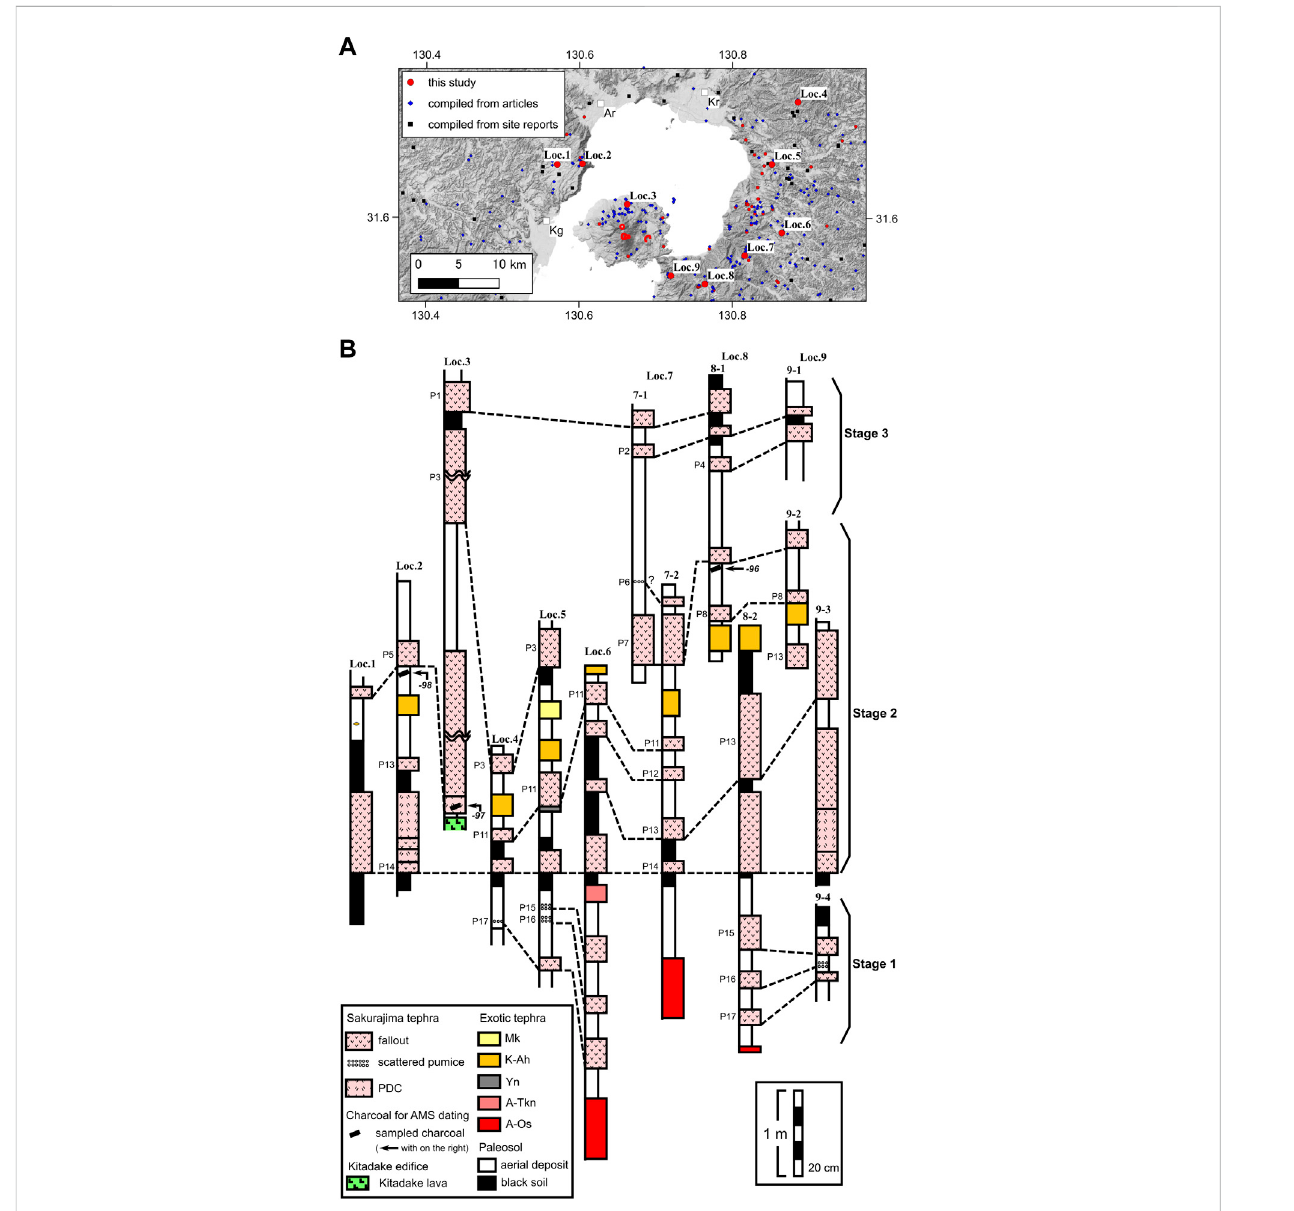
FIGURE 3 (A) Localities of outcrops (solid red circles) around the Sakurajima volcano described in this study. The GSI Maps (Shaded Map and Slope Map; https://maps.gsi.go.jp/development/ichiran.html) published by Geospatial Information Authority of Japan are used as the background maps. (B) Representative columnar sections of Sakurajima volcano. Localities of the sections are described in Figure 3A and listed in Table 1. The numbers accompanying the charcoal are the last two digits of the Lab No. of the 14 C dated sample (Table 2). The abbreviations of exotic tephras are